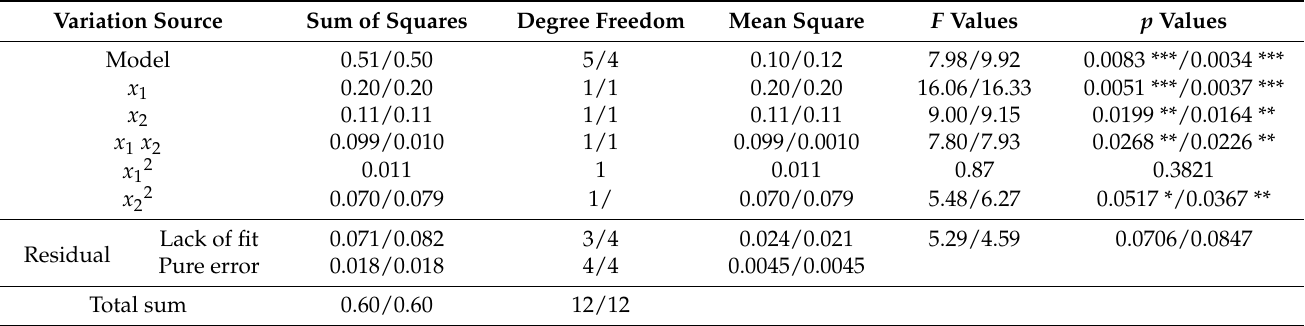
Table 4. Variance of throwing width.